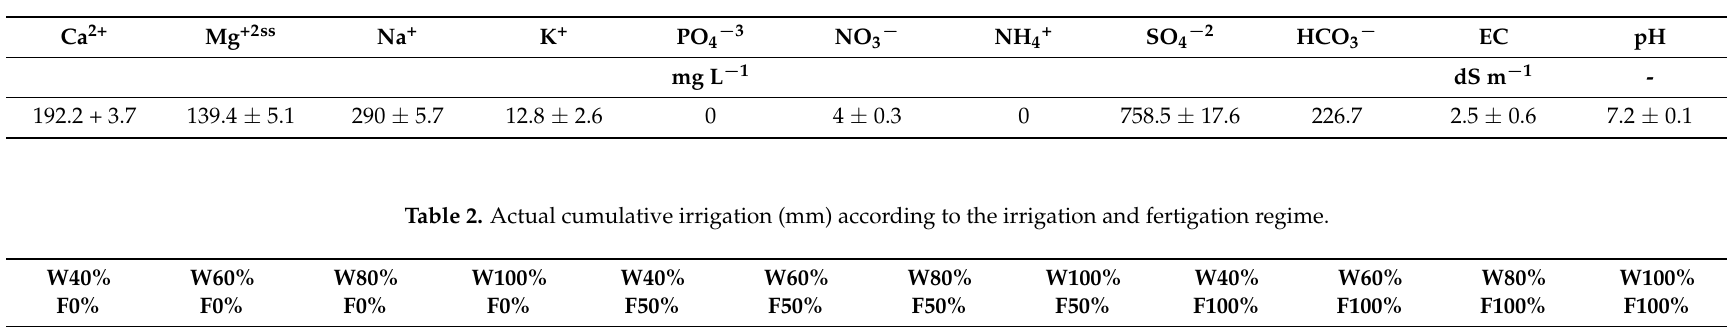
Table 1. Representative Yotvata irrigation water composition.